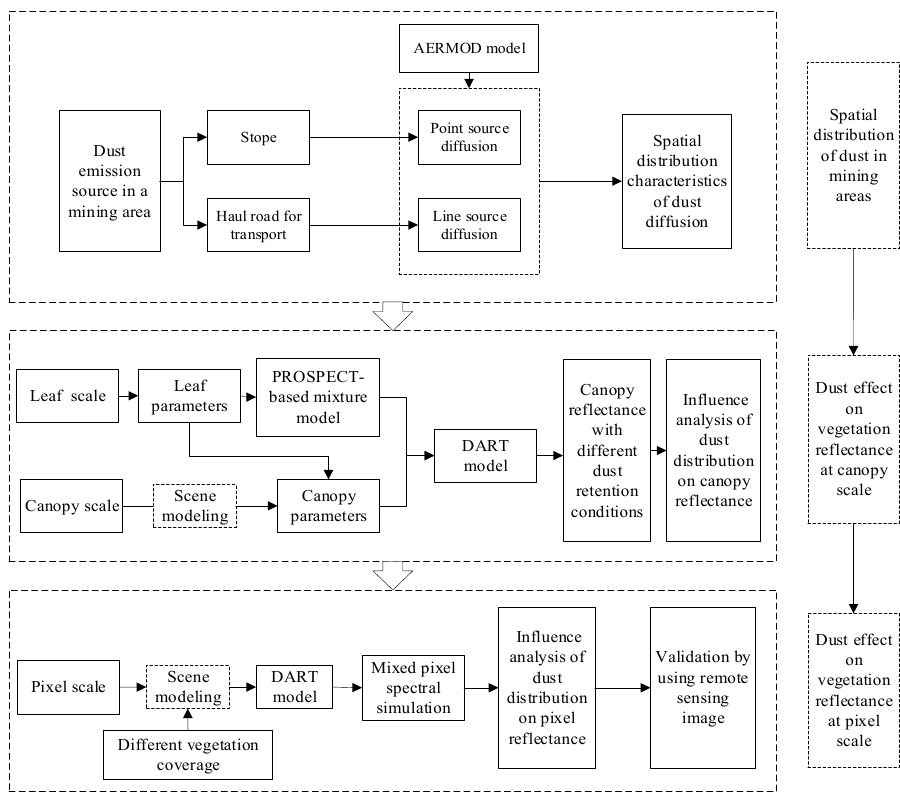
Figure 2. A general flowchart of this study.